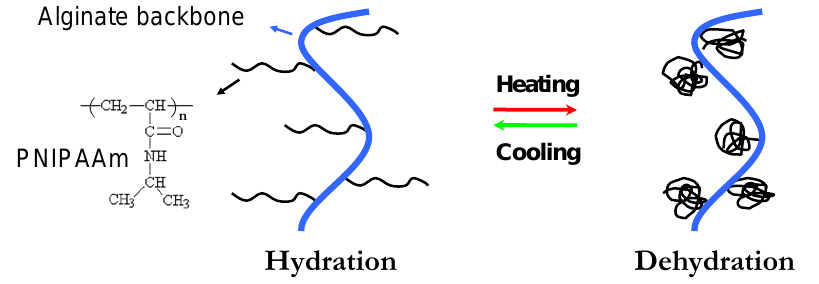
Figure 2. Schematic showing the temperature dependent behavior of PNIPAAm-g- alginate hydrogels. PNIPAAm = Poly( N